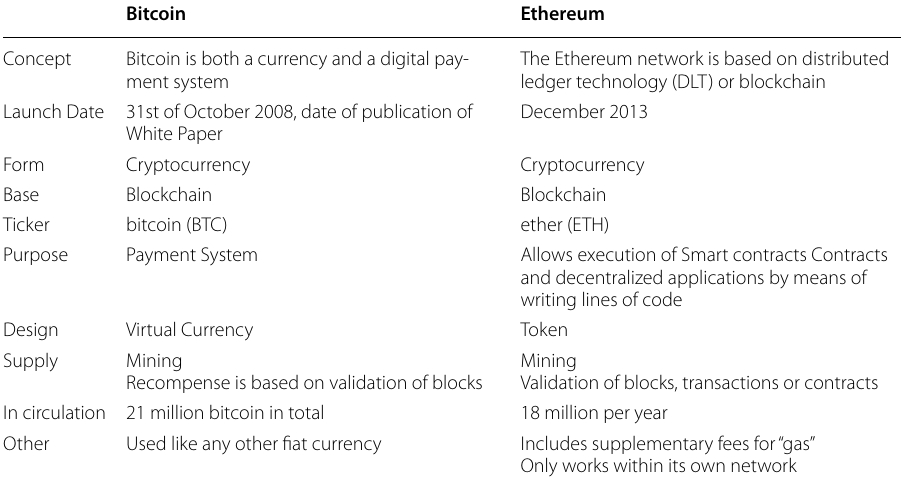
Table 3 Comparison between Bitcoin and